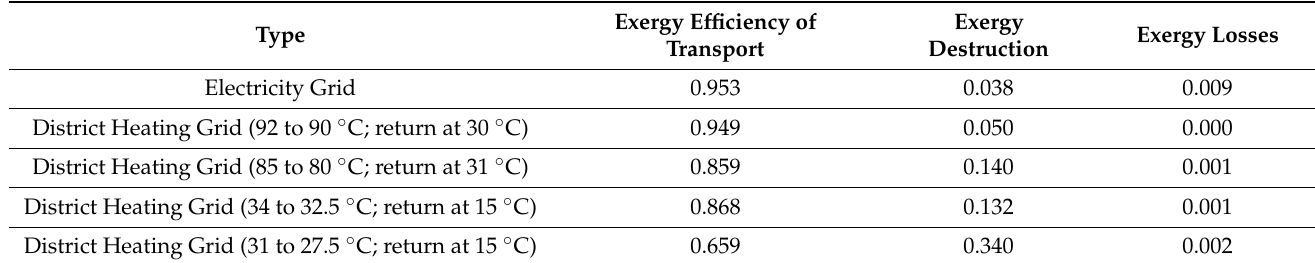
Table A4. Available grids of scenario Energy Efficiency [47].